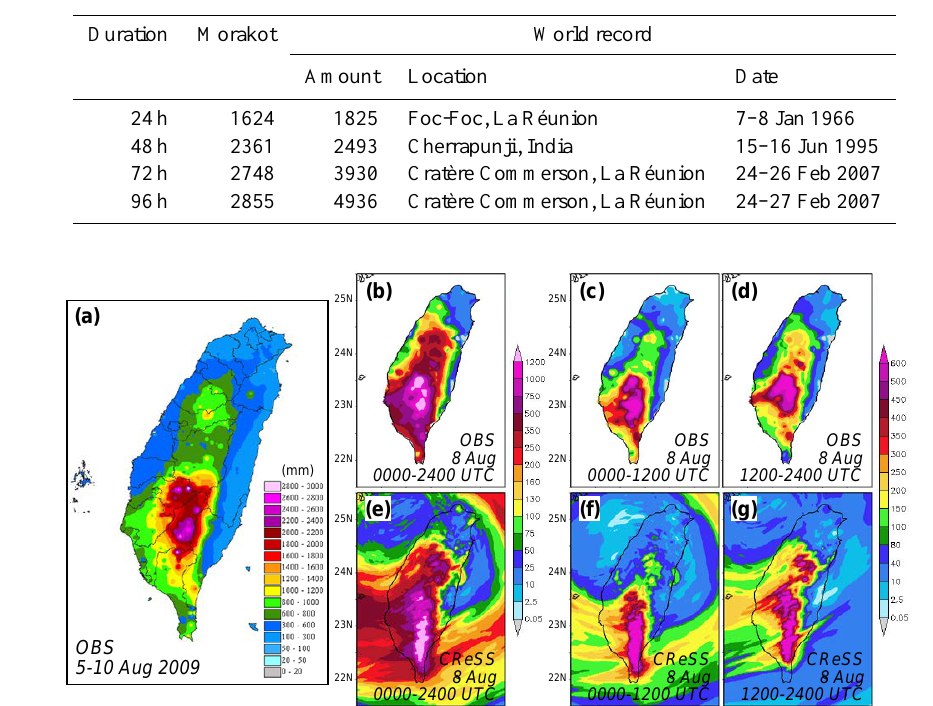
Table 1. Comparison of maximum accumulated rainfall (mm) observed in TY Morakot (2009) in Taiwan (Hsu et al., 2010) and the World’s record rainfall, including location and date (source: World Meteorological Organization World Archive of Weather and Climate Extremes, available at http://wmo.asu.edu/#global; Holland, 1993; Guhathakurta, 2007; Quetelard et al., 2009).